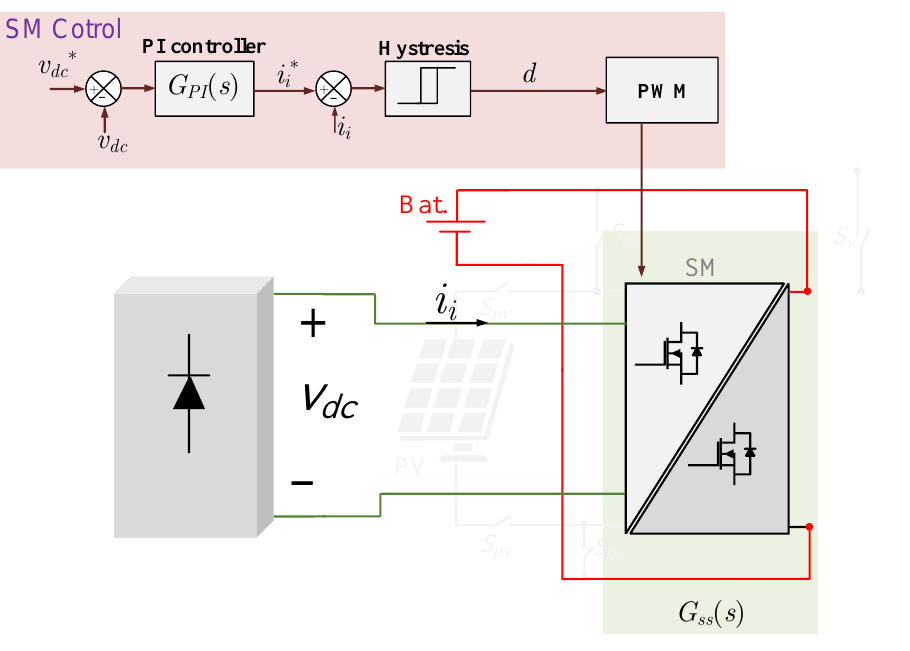
Figure 11. SM control during Mode 1.